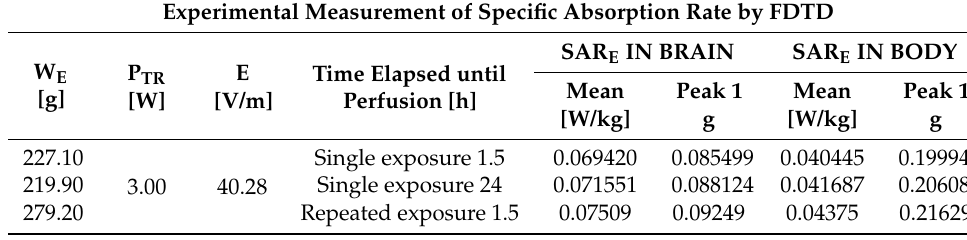
Table 4. Brain and body SAR values for the experimental rats, calculated from the power (P) and electrical field (E).